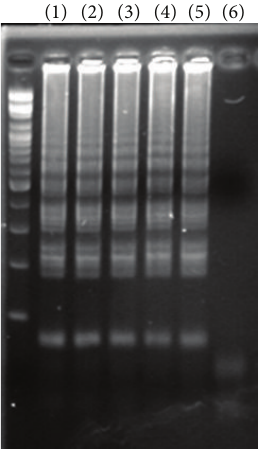
Figure 12: Turbidity in the SPR LAMP reaction in the reservoir of the chip for DNA samples at various concentrations: (1) 20 ng/mL, (2) 2ng/mL, (3) 0.2 ng/mL, (4) 20pg/mL, (5) 2pg/mL, and (6) negative